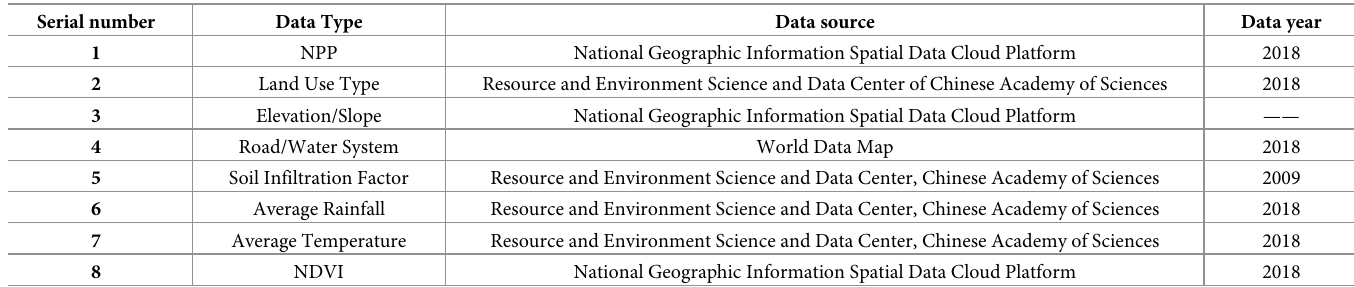
Table 1. Data types and sources.